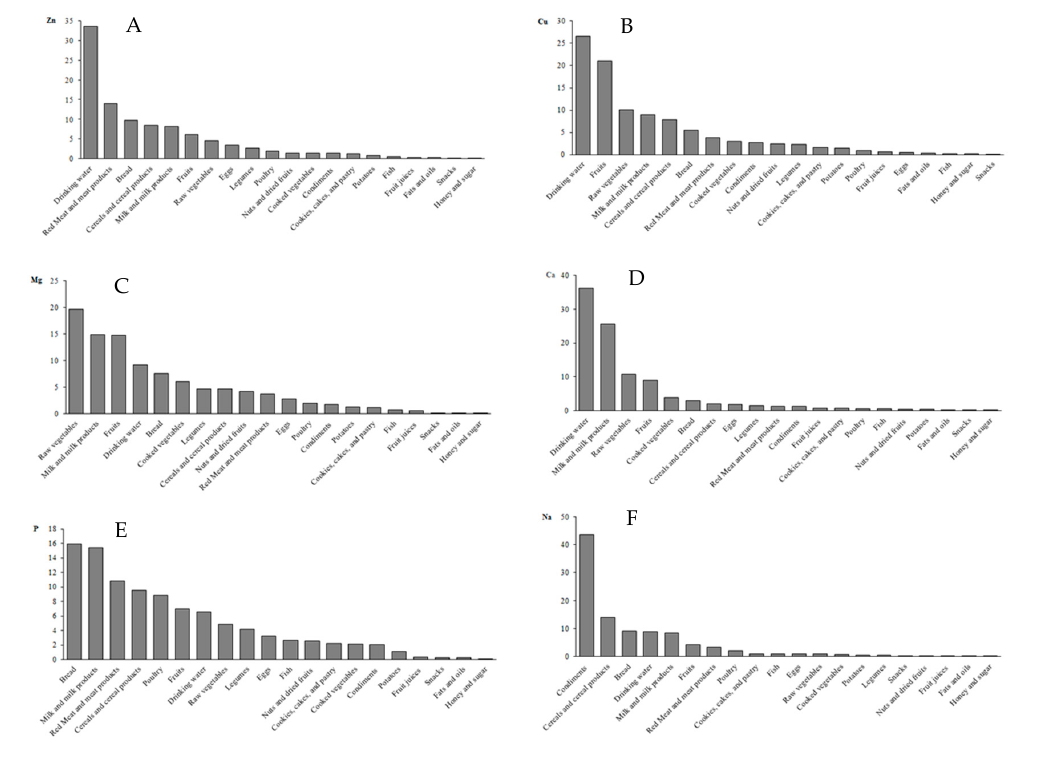
Figure 1. The mean contribution (%) of food groups to dietary intakes of ( A ). zinc (Zn), ( B ). copper (Cu), ( C ). magnesium (Mg), ( D ). calcium (Ca), ( E ). phosphorus (P), and ( F ). sodium (Na) in adult population in Shiraz, Iran.